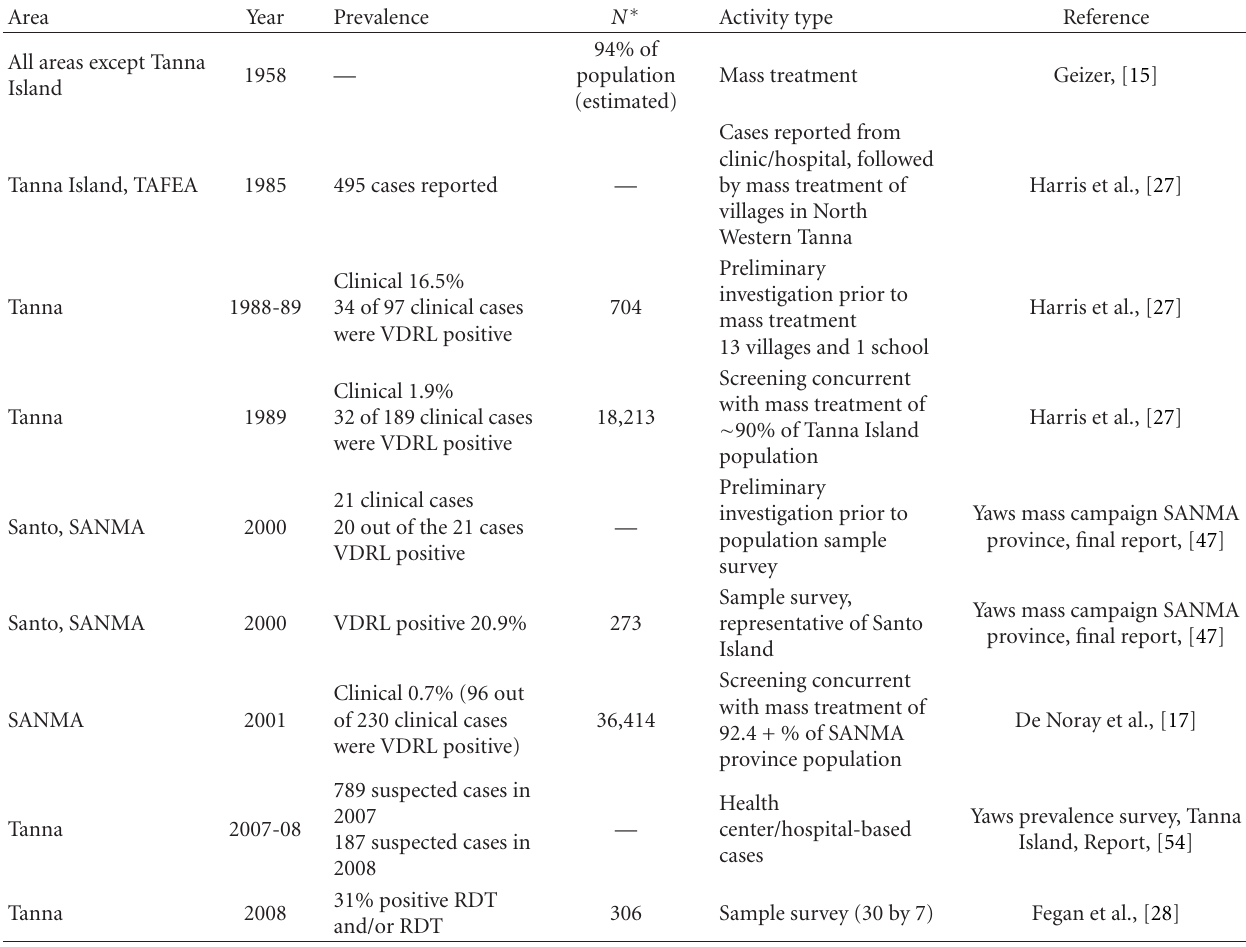
Table 5: Summary of yaws reported cases and prevalence surveys in Vanuatu since 1958.